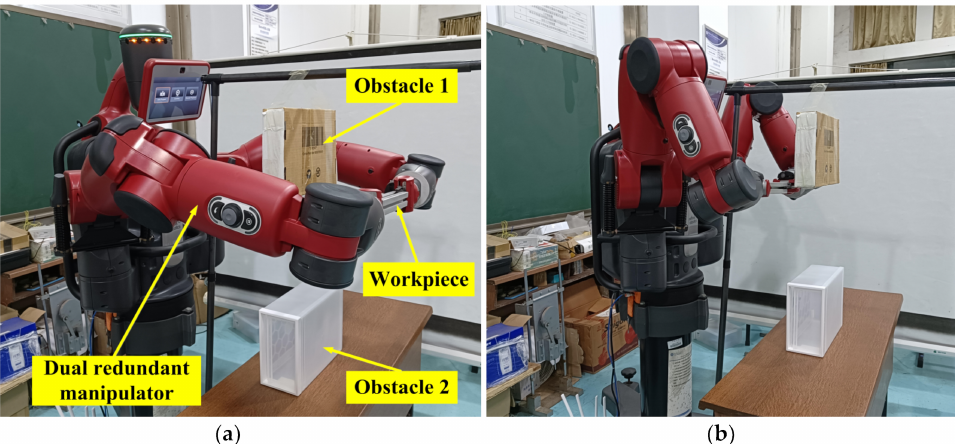
Figure 2. Experimental platform: ( a ) initial state; ( b ) goal state.